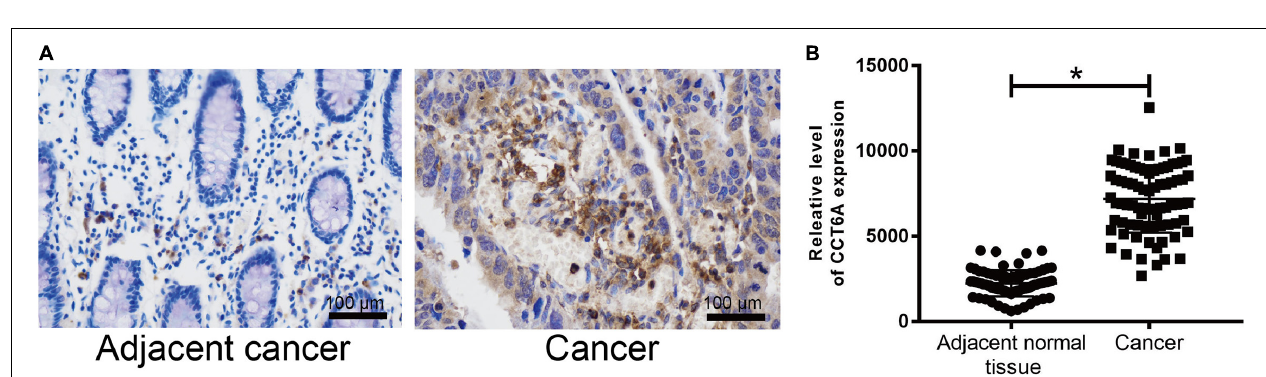
FIGURE 4 | Differential expression analysis of CCT6A gene in pan-cancers. Data are mean SE. * P < 0.05 and ** P < 0.01.